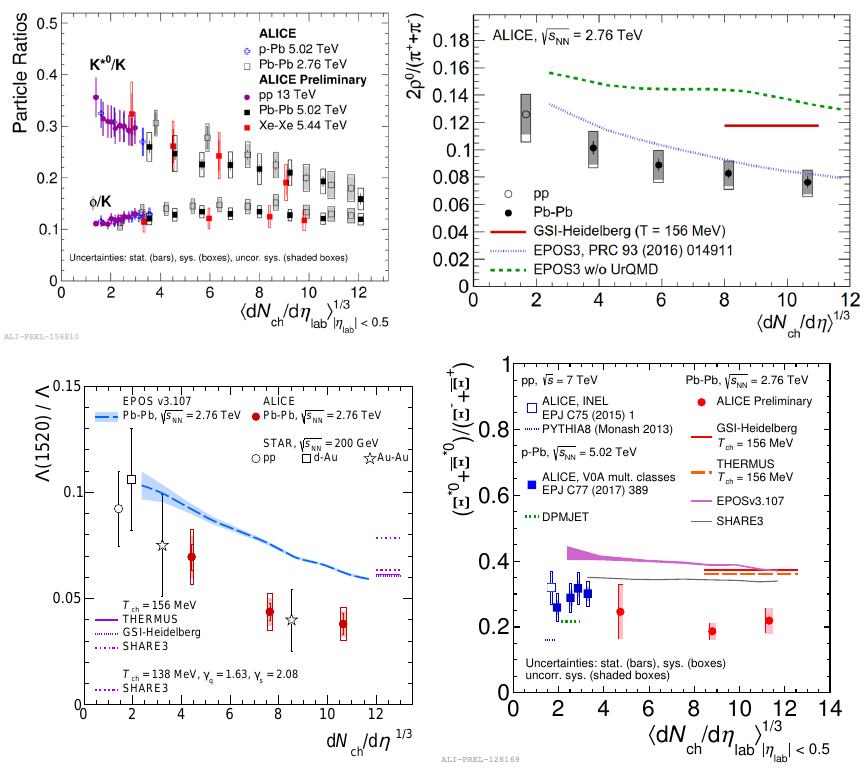
Figure 5. (color online) Particle yield ratios K ∗ 0 / K and φ/ K (top left), ρ 0 /π (top right) [2], Λ ∗ / Λ (bottom left) [7] and Ξ ∗ 0 / Ξ (bottom right) as a function of the charged-particle multiplicity density for various collision systems. STAR data from [14]. The measurements are also compared to model predictions: EPOS3 [11], THERMUS [15], GSI-Helderberg [16], SHARE [17]